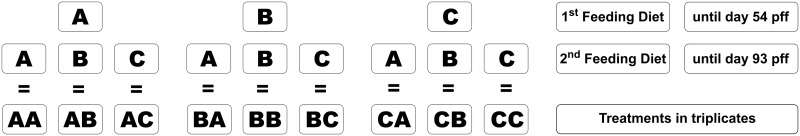
Scheme of the experimental design used in this study.The fishmeal diet A, the intermediate diet B and the plant-based diet C were fed as first feeding diet until day 54 post first feeding, which was the first sampling day for microbiome analysis. Afterwards fish of each dietary group were divided into three subgroups and the same three diets were fed as second feeding diet in a cross-over design until day 93 post first feeding, which was the second sampling day. The treatments reveal the nine resulting combinations of first and second feeding diet.